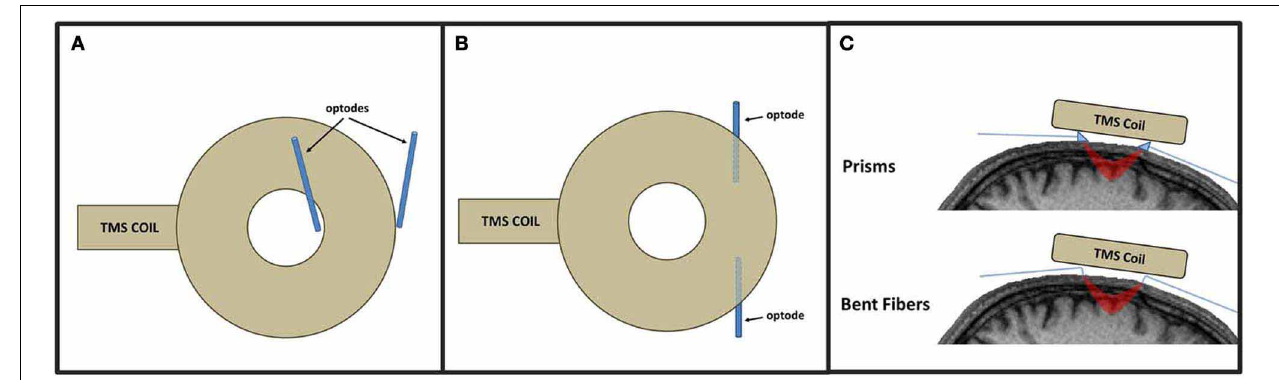
FIGURE 2 | Approaches to TMS-fNIRS and TMS-EROS montages illustrated with a circular coil. In a coil-bounding montage (A) , optodes are arranges around inner and outer edges of a TMS coil. A low-profile approach (B) positions optodes directly beneath the coil by redirecting light with prisms or bending the tips of fiber optics (C)